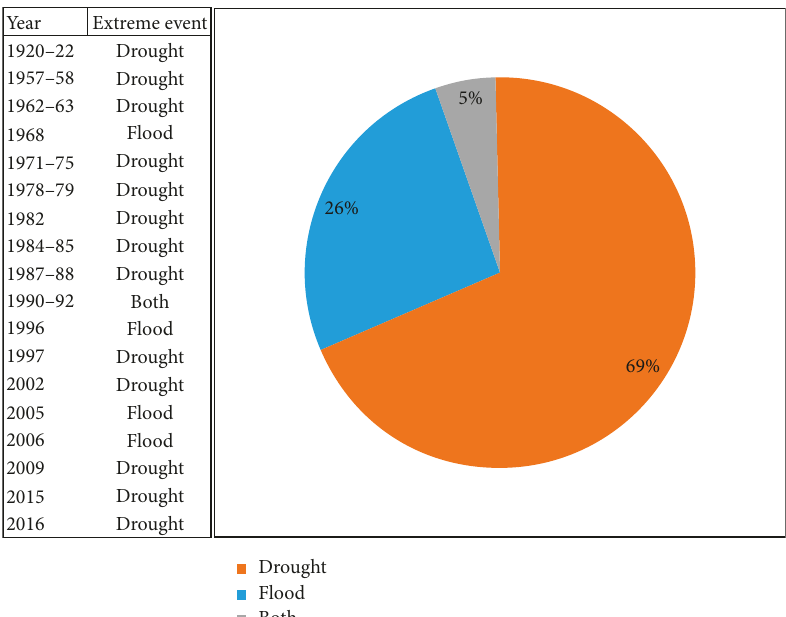
Figure 6: A chronology of extreme events over Ethiopia from 1920 to 2016 compiled and sourced from the studies in [58, 59] and from EM- DAT: The OFDA/CRED International Disaster Database